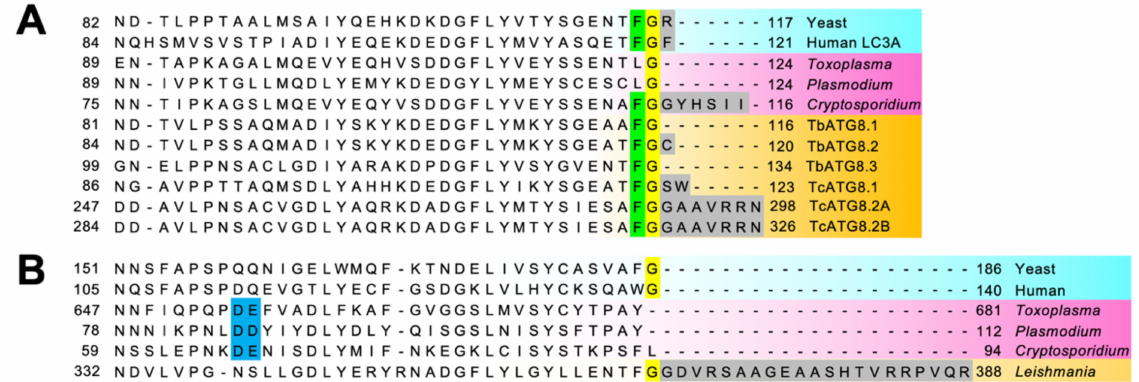
Figure 5. Sequence alignment of the C-terminal regions of ATG8 and ATG12 homologs from selected protists and human and yeast counterparts. ( A ) Sequences of ATG8 homologs from S. cerevisiae (Yeast), H. sapiens (Human LC3A), T. gondii (TGGT1_254120), P. falciparum (PF3D7_1019900), C. parvum (XP_001388400.1), T. brucei TbATG8.1 (Tb927.7.5900), TbATG8.2 (Tb927.7.5910), TbATG8.3 (Tb927.7.3320), T. cruzi TcATG8.1 (TcCLB.508173.47), TcATG8.2 (TcCLB.510533.180), TcATG8.2b (TcCLB.511821.160) are shown. The Gly residue that is responsible for conjugation with PE is highlighted in yellow. Green and gray highlight the highly conserved aromatic amino acids before one of the Gly and the C-terminal extension after the Gly, respectively. ( B ) Sequences of ATG12 homologs from S. cerevisiae (Yeast), H. sapiens (Human LC3A), T. gondii (TGGT1_321300), P. falciparum (PF3D7_1470000), C. parvum (cgd7_3873), L. major (LmjF22.1300) are shown. The Gly residue that is responsible for conjugation with ATG5 is highlighted in yellow. Blue and gray highlight positively charged amino acids that are critical for the interaction with ATG5 in Apicomplexa and the C-terminal extension after the Gly,